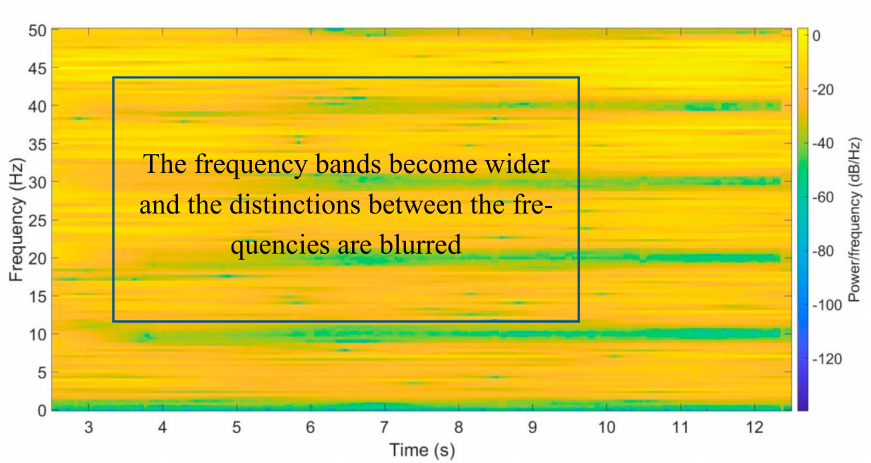
Figure 26. STFT results of right rear axle acceleration history of the vehicle on undamaged bridges with the given